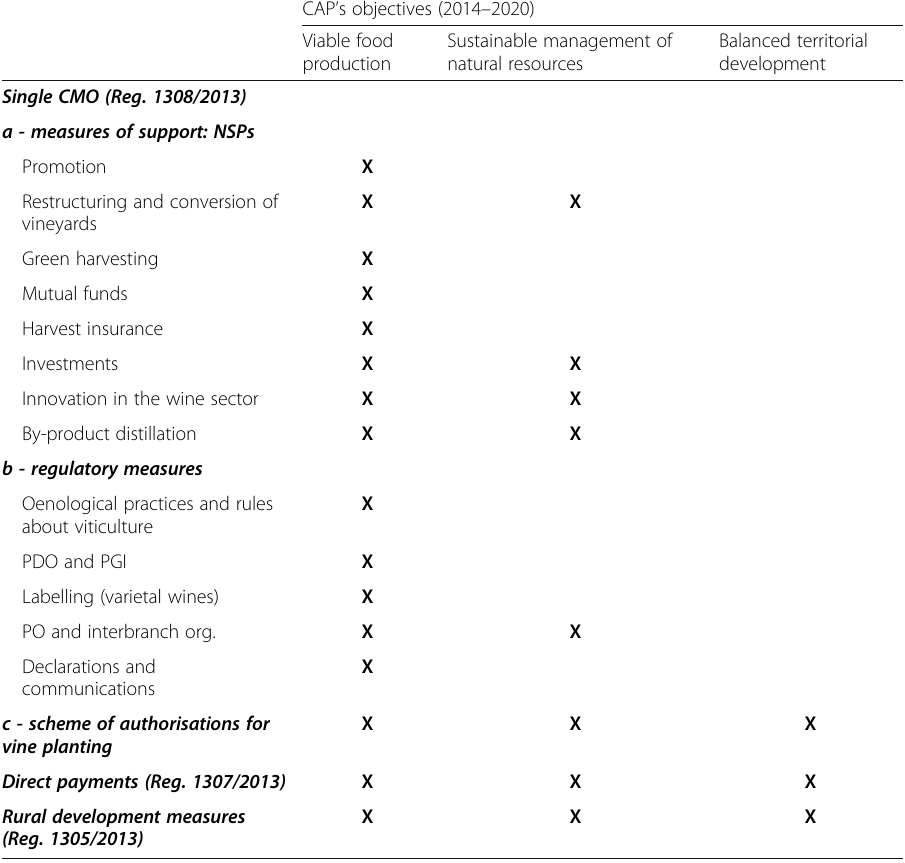
Table 4 Relationship between CAP objectives and measures of wine policy (2014 –